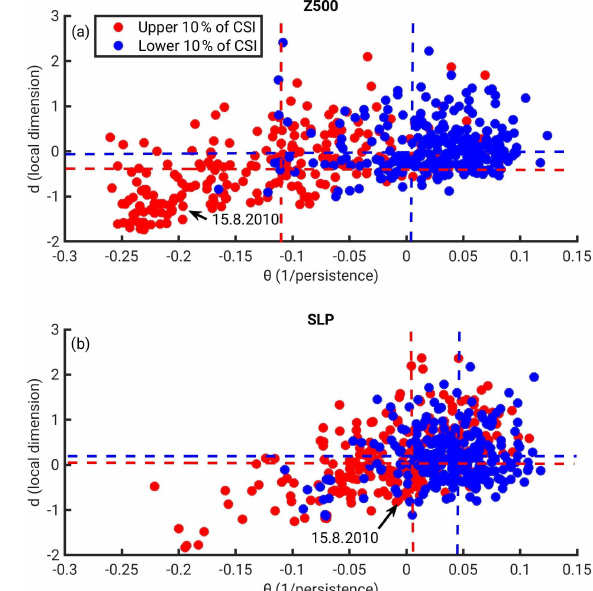
Figure 3. A phase plane diagram for the upper and lower 10% of CSI daily values (heat waves in red and cool days in blue). The de- seasonalized dynamical systems metrics ( d and θ ) were computed for (a) Z 500 and (b) SLP. Dashed lines represent the median values of d and θ . The 15 August 2010 is indicated by the black arrows.